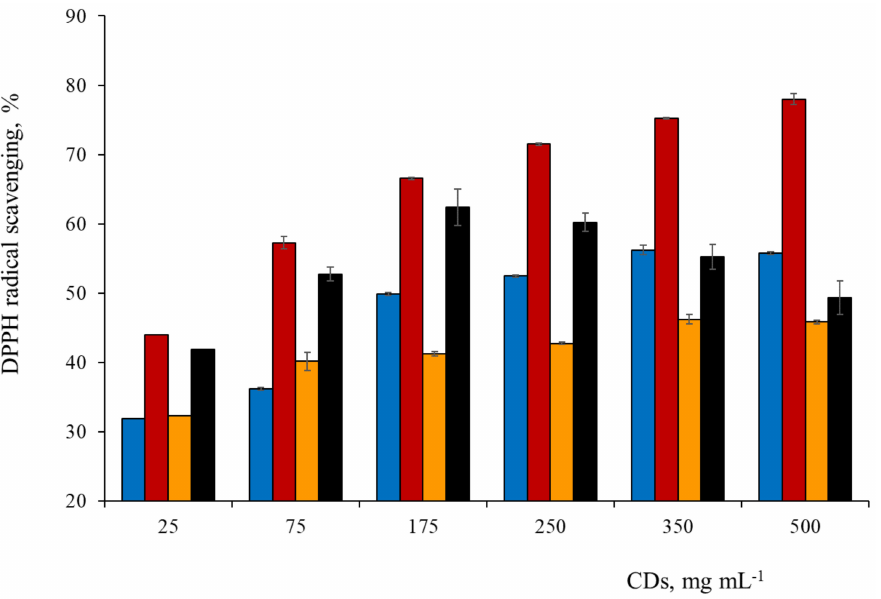
Figure 6. Antioxidant activity of the CDs at di ff erent concentrations: TCDs ( (cid:4) ), GCDs ( (cid:4) ), P1CDs ( (cid:4) ) and P2CDs ( (cid:4) ).